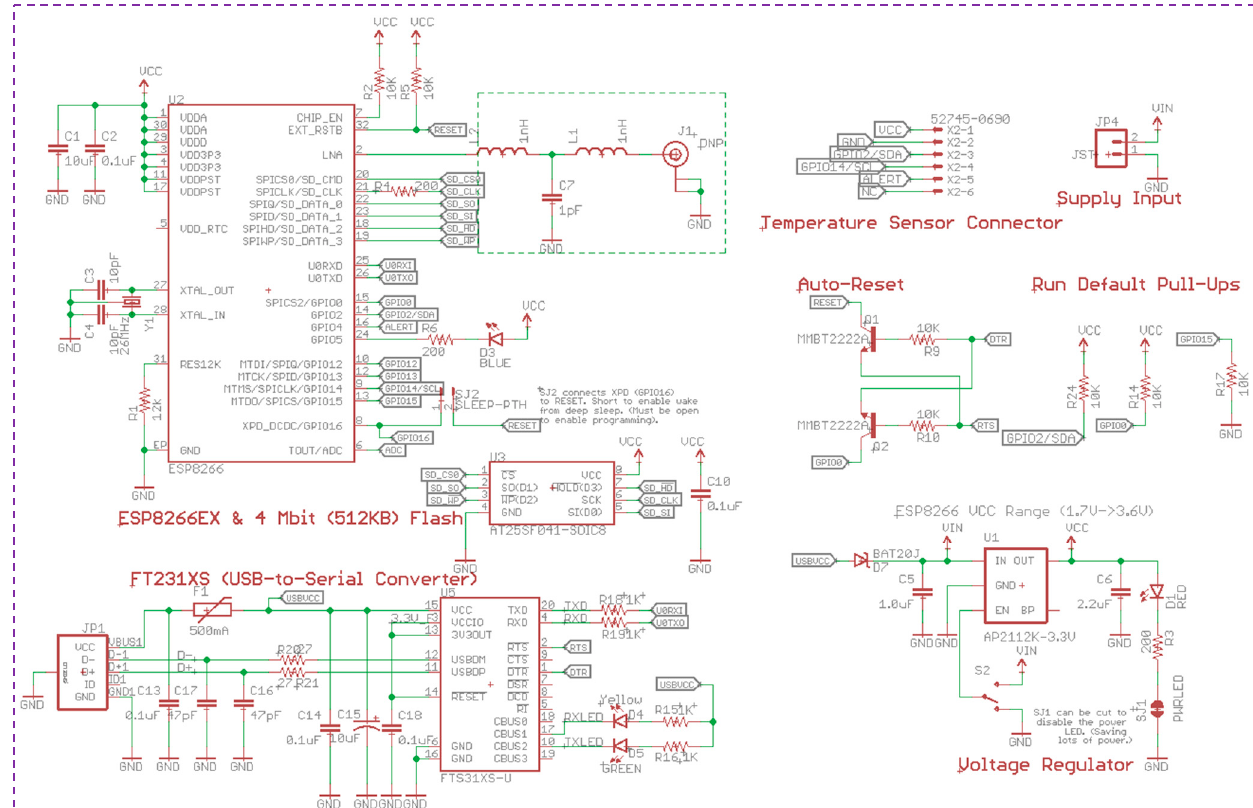
Figure A1. A full schematic design of an integrated PCB design.